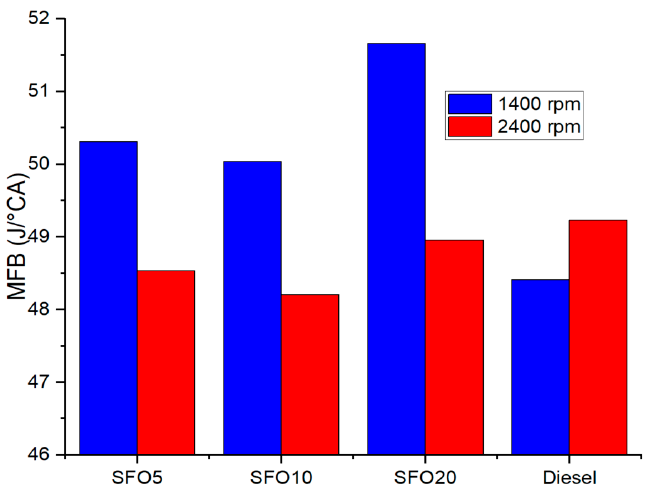
Figure 12. The variations in mass fraction burned (%) for SFO blends and diesel under 100% engine load at speeds of ( i ) 1400 rpm and ( ii ) 2400 rpm.